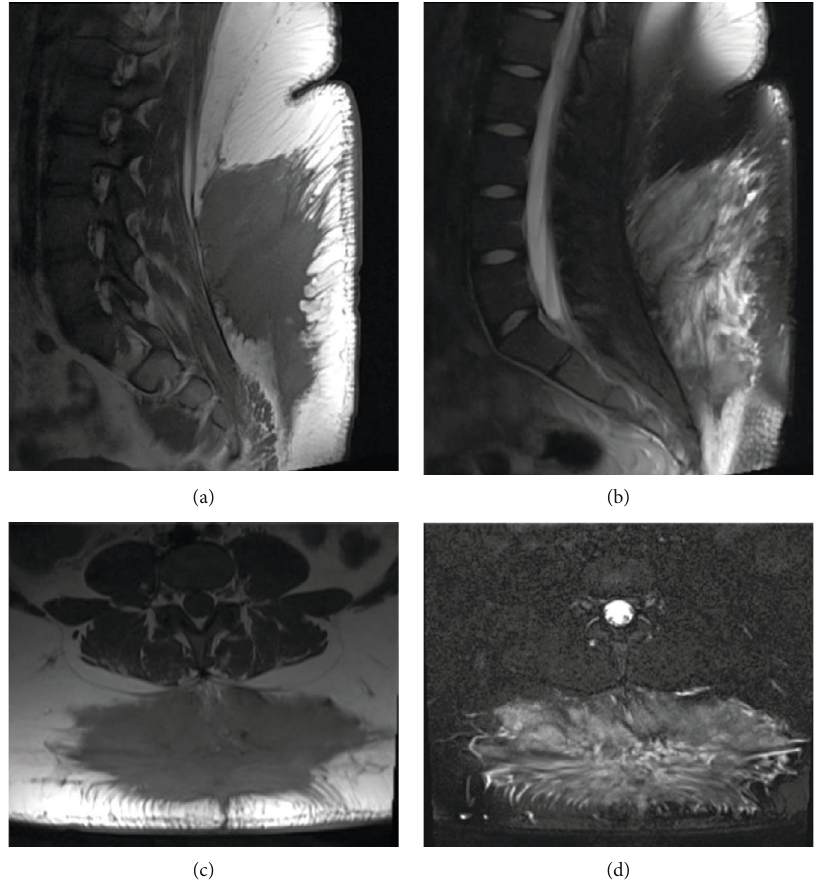
Figure 3: Representative 9-month postoperative 1.5 Tesla MRI images. (a) T1 sagittal (TR 500ms, TE 17ms). (b) T2 FS sagittal (TR 4,770ms, TE 83 ms). (c) T1 axial (TR 600ms, TE 19 ms). (d) T2 FS axial (TR 6,580ms, TE 100 ms). These images revealed a large T1 hypointense, T2 heterogeneously hyperintense, and enhancing lesion with irregular borders, measuring approximately 21.5 × 7 × 15 cm (transverse × anteroposterior × craniocaudal). There was a central stellate/spiculated portion of the lesion, which was a relatively nonenhancing region and suggestive of an area of postsurgical scarring. Surrounding this region was a more T2 hyperintense multilobulated appearing component. No other lesions were seen. FS = fat suppression, TR = repetition time, and TE = echo